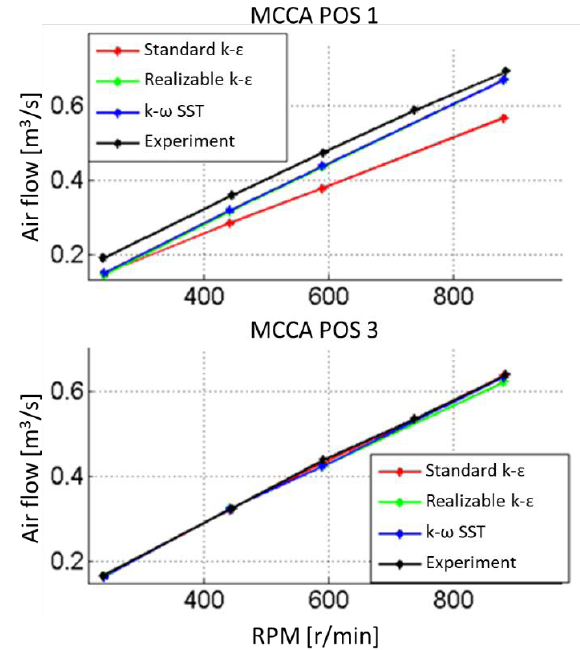
Fig. 6. Simulation results for different models of